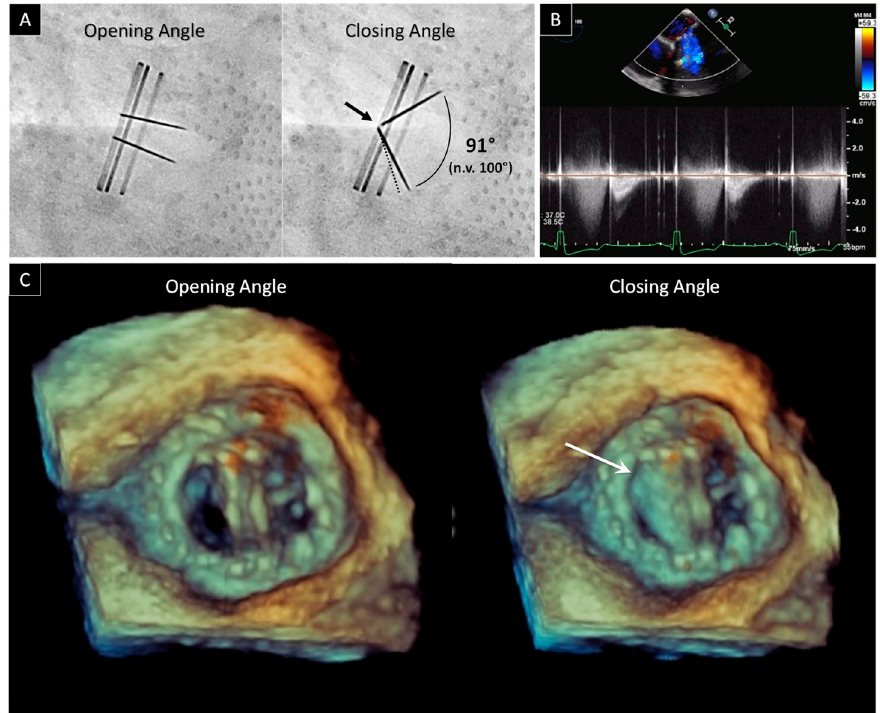
Figure 1. Bileaflet mechanical mitral valve obstruction. ( A ) Fluoroscopic evaluation of normal opening and abnormal closing angles in a patient with prosthetic mitral valve dysfunction. The dotted line refers to the normal leaflet closure. The abnormal leaflet closure was confirmed by the lack of leaflets contact at the hinge area (black arrow). ( B ) Holosystolic regurgitation at continuous wave Doppler by TEE. ( C ) 3D view of prosthetic mitral valve from atrial side. During systole, only one leaflet closes (white arrow).